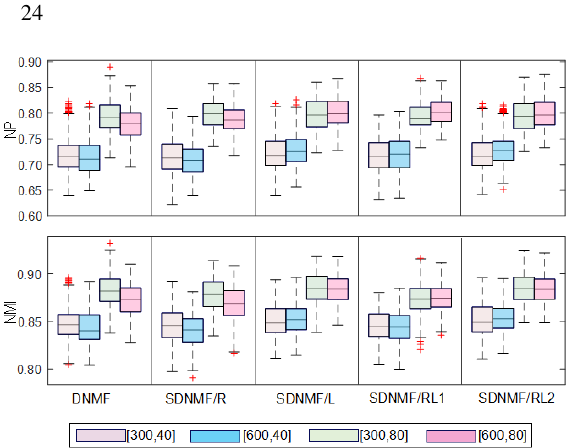
Fig. 6 Correspondent comparison between two-layer and three layer linear deep models on PIE-pose 27.0 dataset. Specifically, the layer size for three-layer model contains [600,160, 40], [600,160, 80], and [600,160,120]. The layer size for our two-layer models is [600,160].